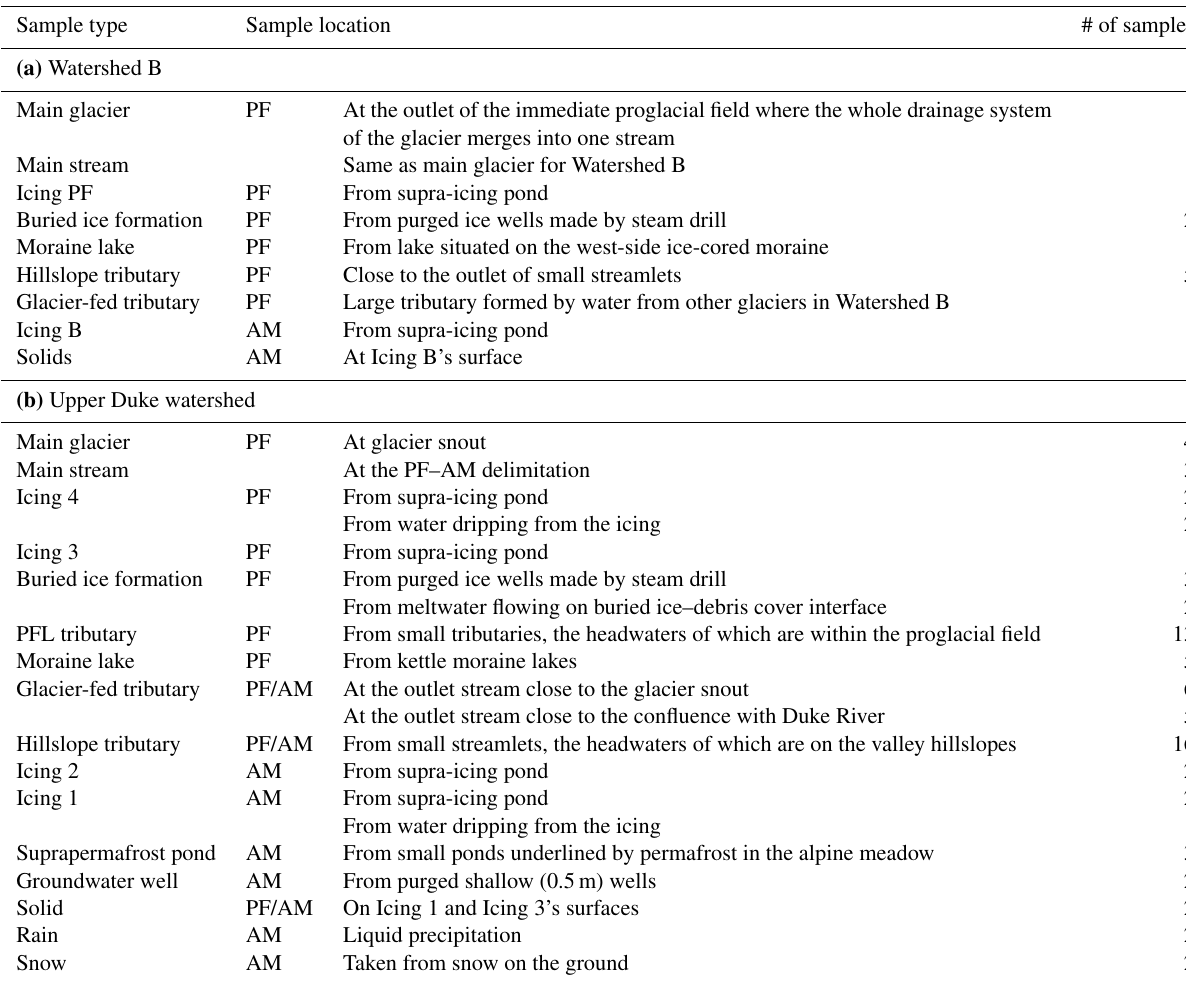
Table 1. Summary of samples collected in (a) Watershed B and (b) Duke watershed. PF stands for proglacial field, and AM stands for alpine